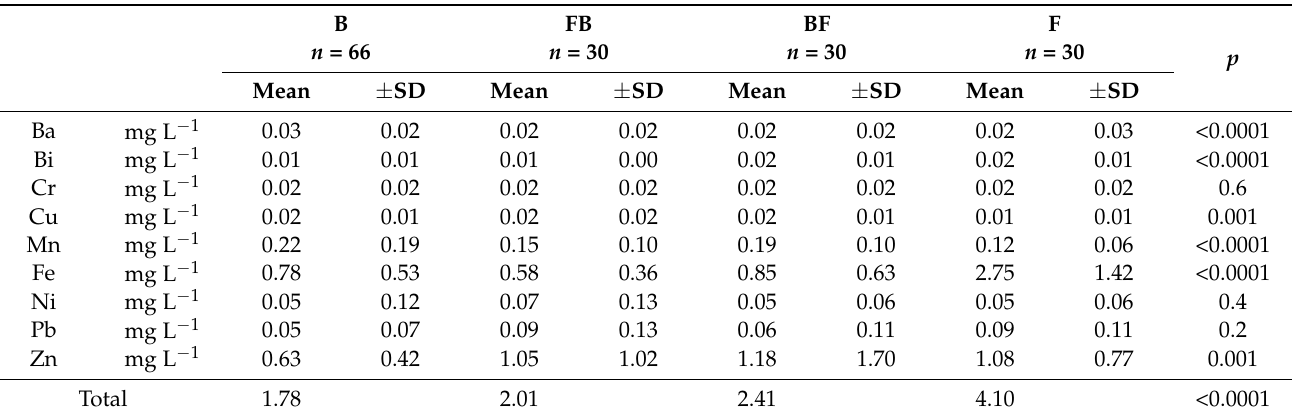
Table 2. Concentrations of heavy metals (mean value ± standard deviation) in the surface water of four types of coastal lakes ( n = 156), and the results of one-way ANOVA evaluating variation between